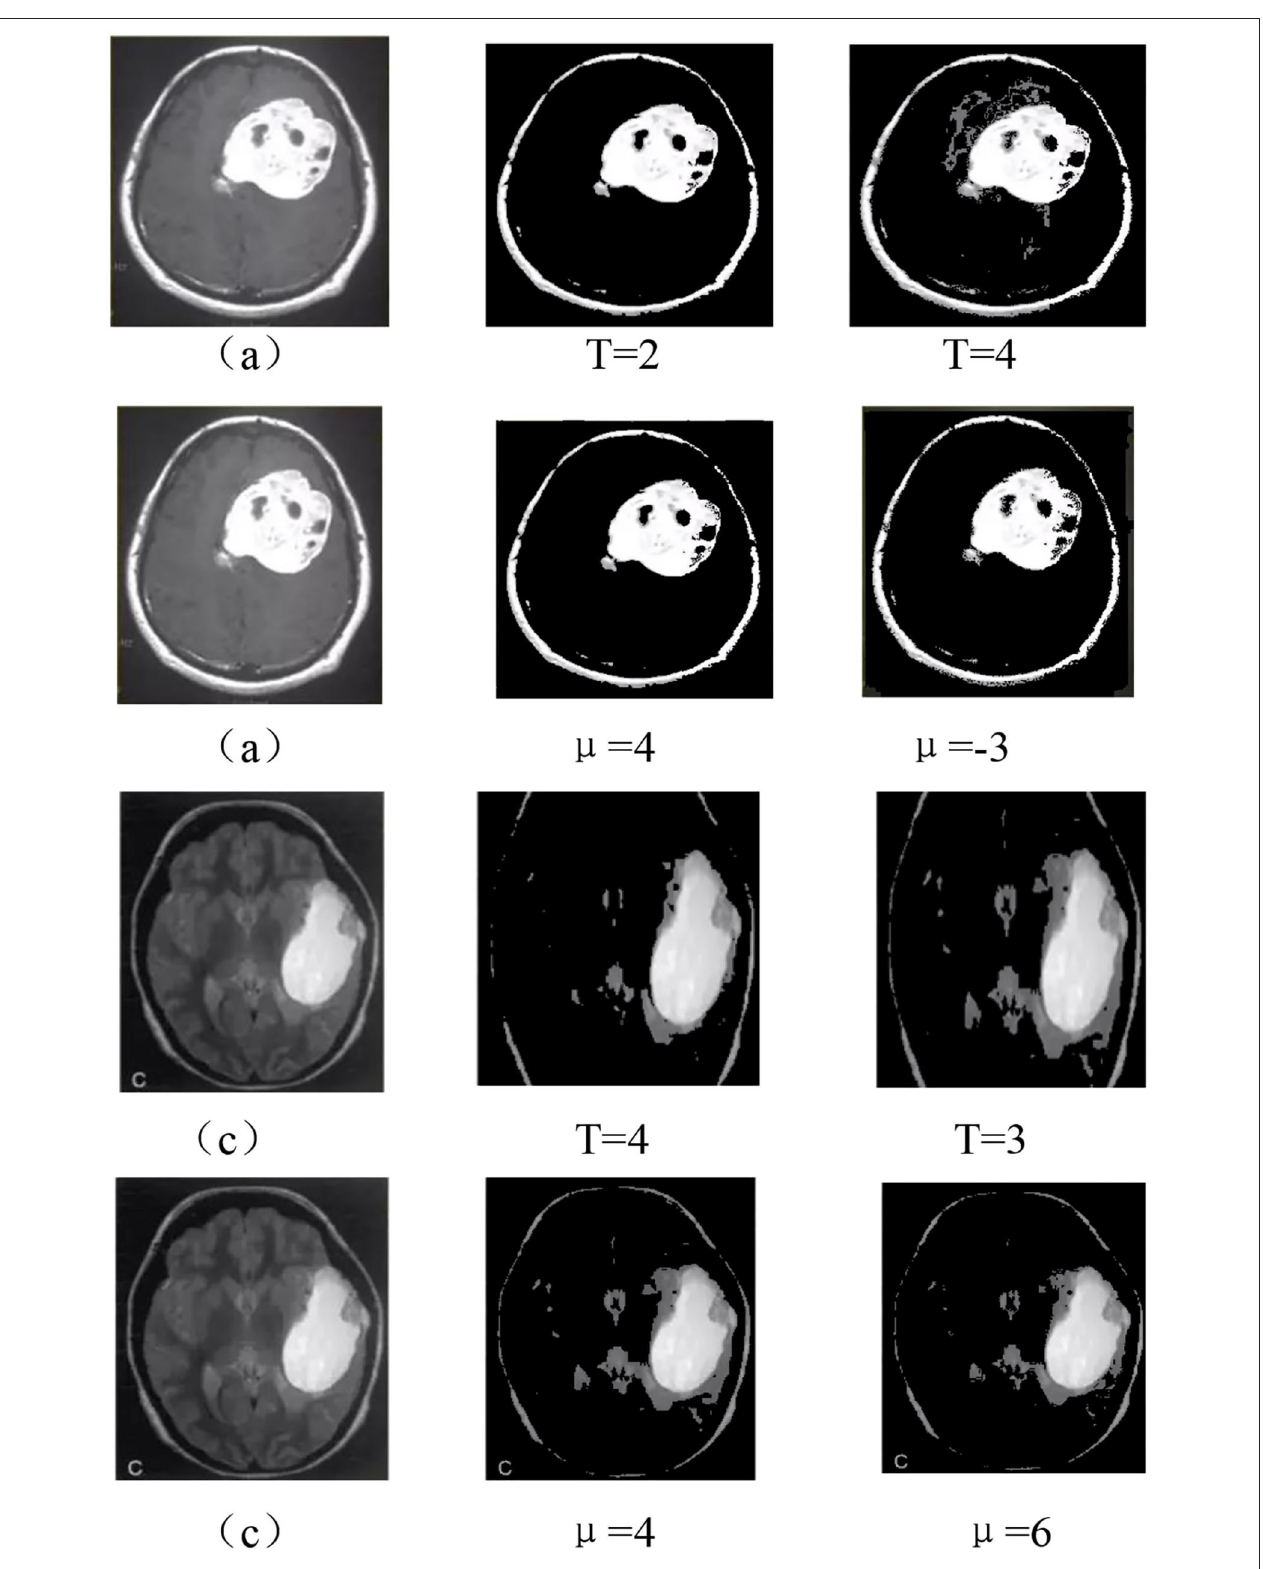
FIGURE 16 | Image group 4 and its best value segmentation